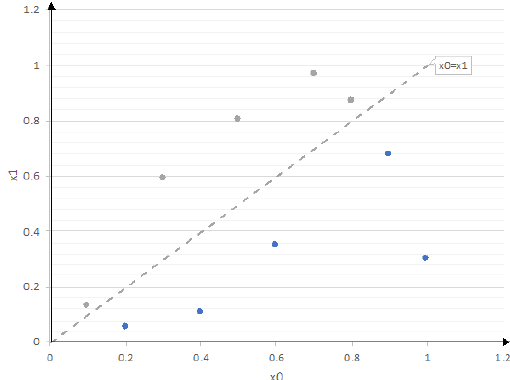
Figure 7. A set of algorithm particles. Equation (37) represents the i -th dimension element of the particle mapped to the decision variable. The element of θ is composed of the angle between X and its axes (the number of axes is determined by the number of elements contained in X ). Equation (38) represents the process of mapping continuous particles into discrete decision variables.